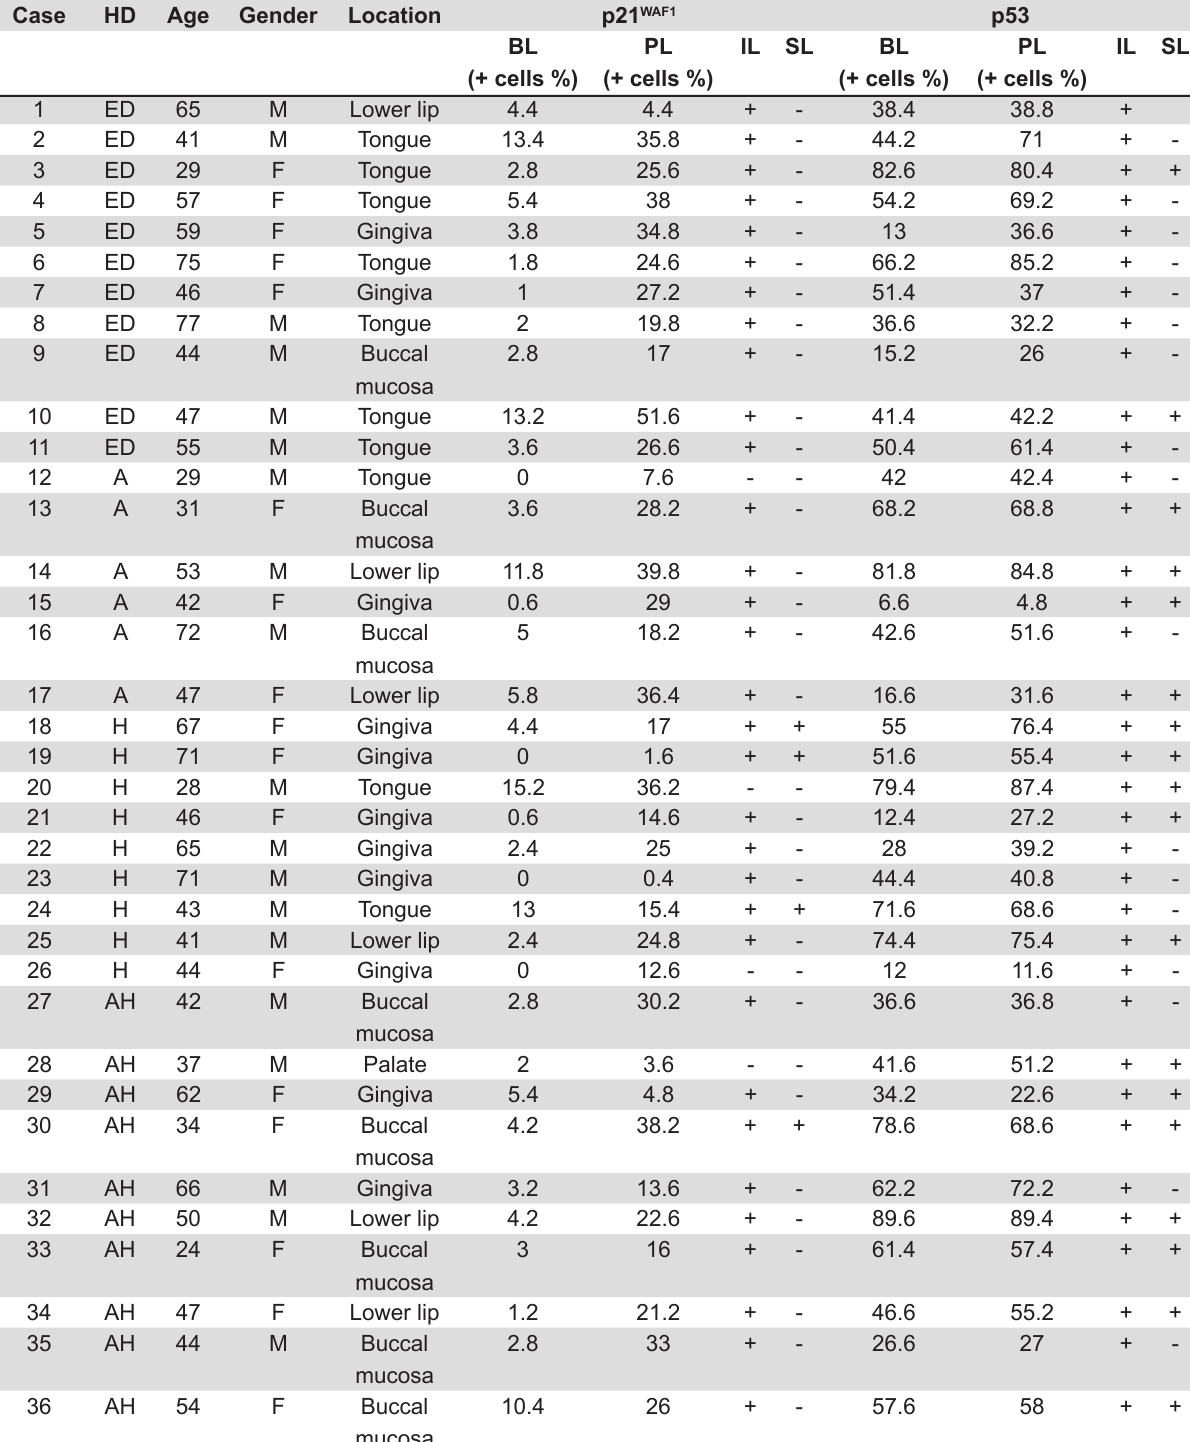
Table 1- Clinicopathological characteristics of leukoplakias and patterns of p53 and p21 WAF1